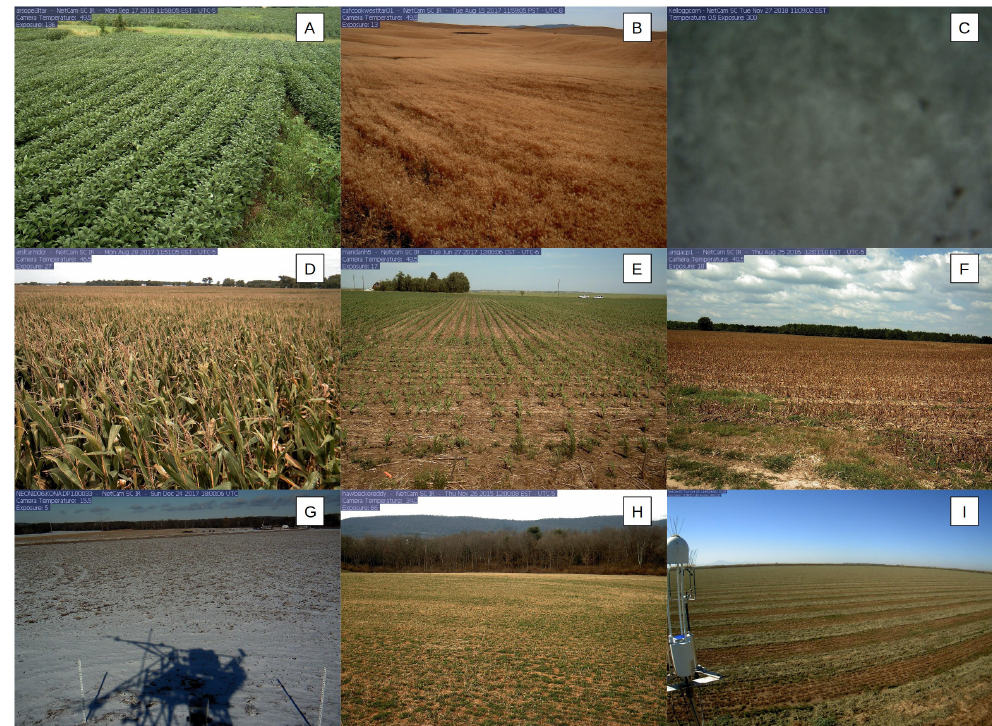
Figure 1. Example images from the PhenoCam network used in this study. The image sources and annotations are as follows: ( A ) is from arsope3ltar on 17 September 2018 with soybeans in the growth stage, ( B ) is from cafcookwestltar01 on 15 August 2017 with wheat which is fully senesced, ( C ) is kelloggcorn on 27 November 2018 and is blurry for all categories, ( D ) is arsltarmdcr on 28 August 2017 with corn in the flowers stage, ( E ) is from mandanh5 on 27 June 2017 and has corn in the growth stage with a dominant cover of residue, ( F ) is from arsgacp1 on 25 August 2016 with dominant cover of plant residue and no crop present, ( G ) is from NEON.D06.KONA.DP1.00033 on 24 December 2017 with dominant cover of snow and no crop present, ( H ) is from hawbeckereddy on 26 November 2015 with an unknown crop type in the growth state, and ( I ) is from bouldinalfalfa on 22 October 2019 with a dominant cover of residue and no crop present. Images ( A , B , D , H ) all have vegetation as the dominant cover